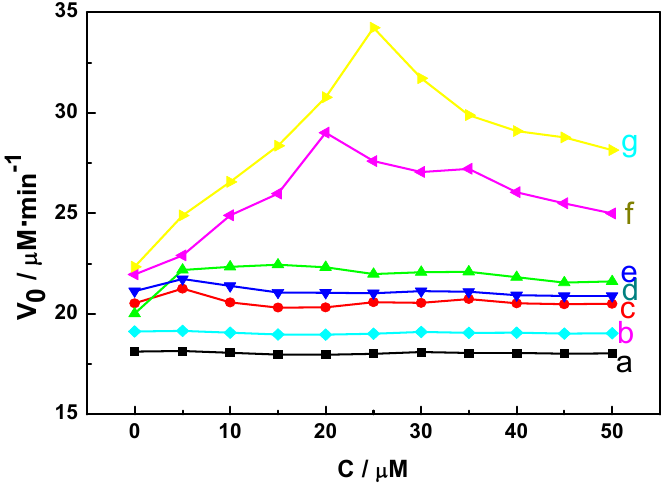
Figure 4. The effects of Al species and other interference factors on the activity of